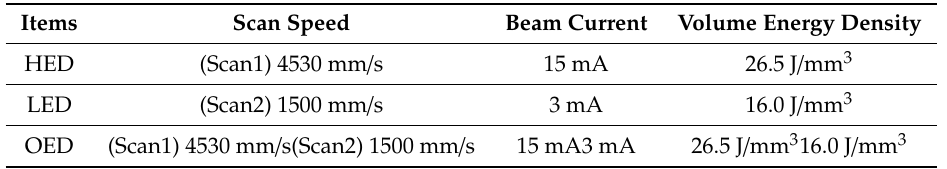
Table 2. Main process parameters with fixed layer thickness 50 µ m, beam diameter of 100 µ m and hatch spacing of 150 µ m used for the SEBAM